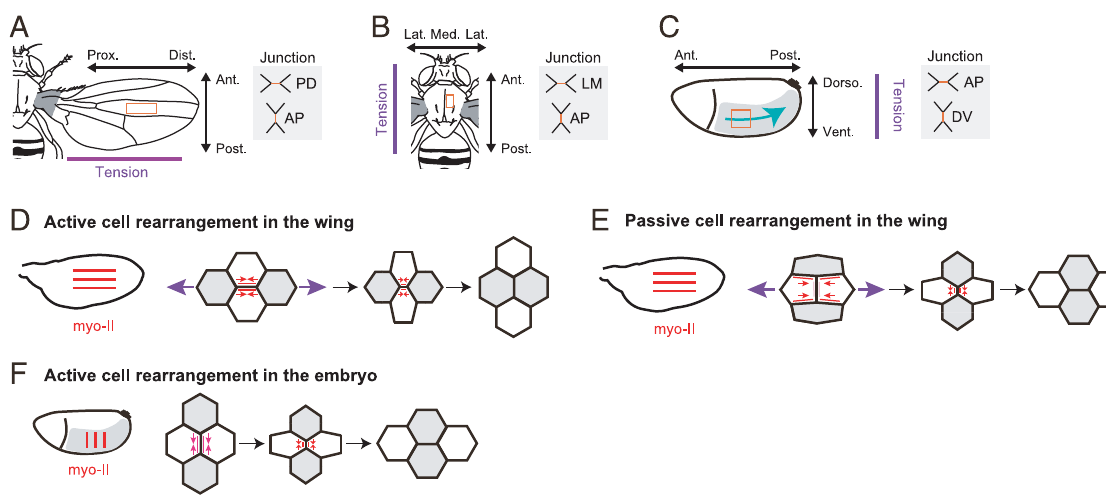
Fig 2. Drosophila epithelial tissues examined in this study. (A–C) Schematics of the adult fly (adapted from [69])(A, B) and of the fly embryo at the germband elongation (GBE) stage (C). Orange rectangles indicate the regions studied in this study. Purple lines indicate the orientation of tissue tension. Schematics of junction are shown in the right. (A) The hinge is shaded gray. In this and all subsequent figures showing the wing, the vertical and horizontal directions are aligned with the AP and PD axes, respectively. (B) In this and all subsequent figures showing the notum, the vertical and horizontal directions are aligned with the AP and ML axes, respectively. (C) In this and all subsequent figures showing the embryo, the vertical and horizontal directions are aligned with the DV and AP axes, respectively. A cyan arrow indicates cell flow during GBE. (D–F) Schematics showing active cell rearrangement in the pupal wing (D), passive cell rearrangement in the pupal wing (E), and active cell rearrangement in the embryo at the GBE stage (F). In the left panels, red lines indicate the global myo-II polarity in tissues. In the right panels, red/pink arrows and purple arrows indicate junction tension and extrinsic pulling forces from the hinge, respectively. Line color represents the local myo-II concentration along the junction. Cells localize myo-II on PD junctions to resist extrinsic pulling forces from the hinge (red lines in D). The myo-II enrichment along the remodeling junctions is indicated by the change in line colors from pale pink to red along the vertical shrinking junction in E and from dark pink to red along the vertical shrinking junction in F.